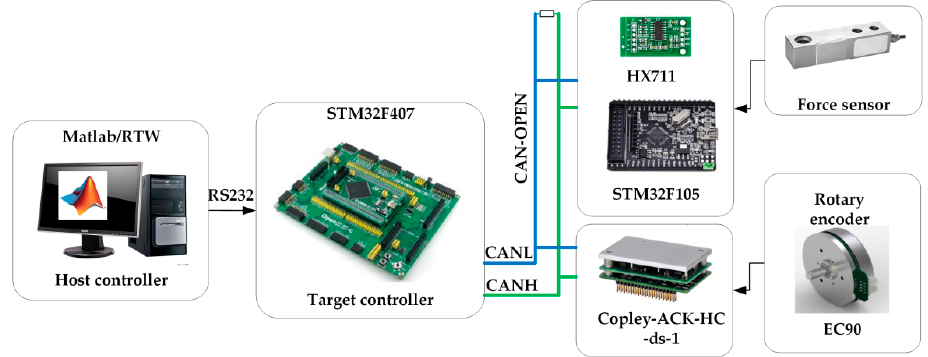
Figure 3. Real-time control system of the exoskeleton.